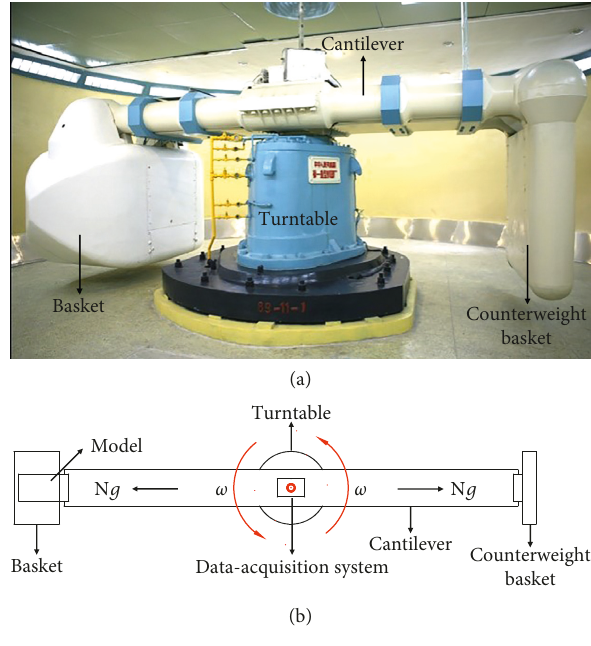
Figure 1: The LXJ-4-450